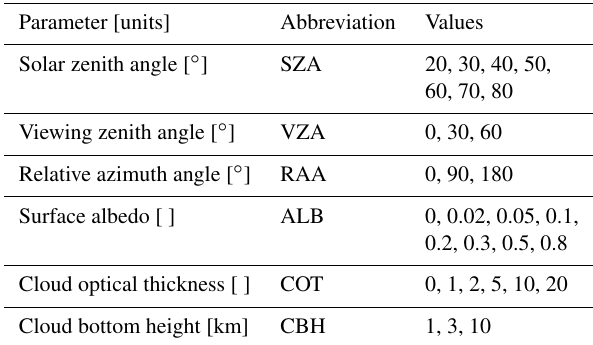
Table 1. Settings for the 1D